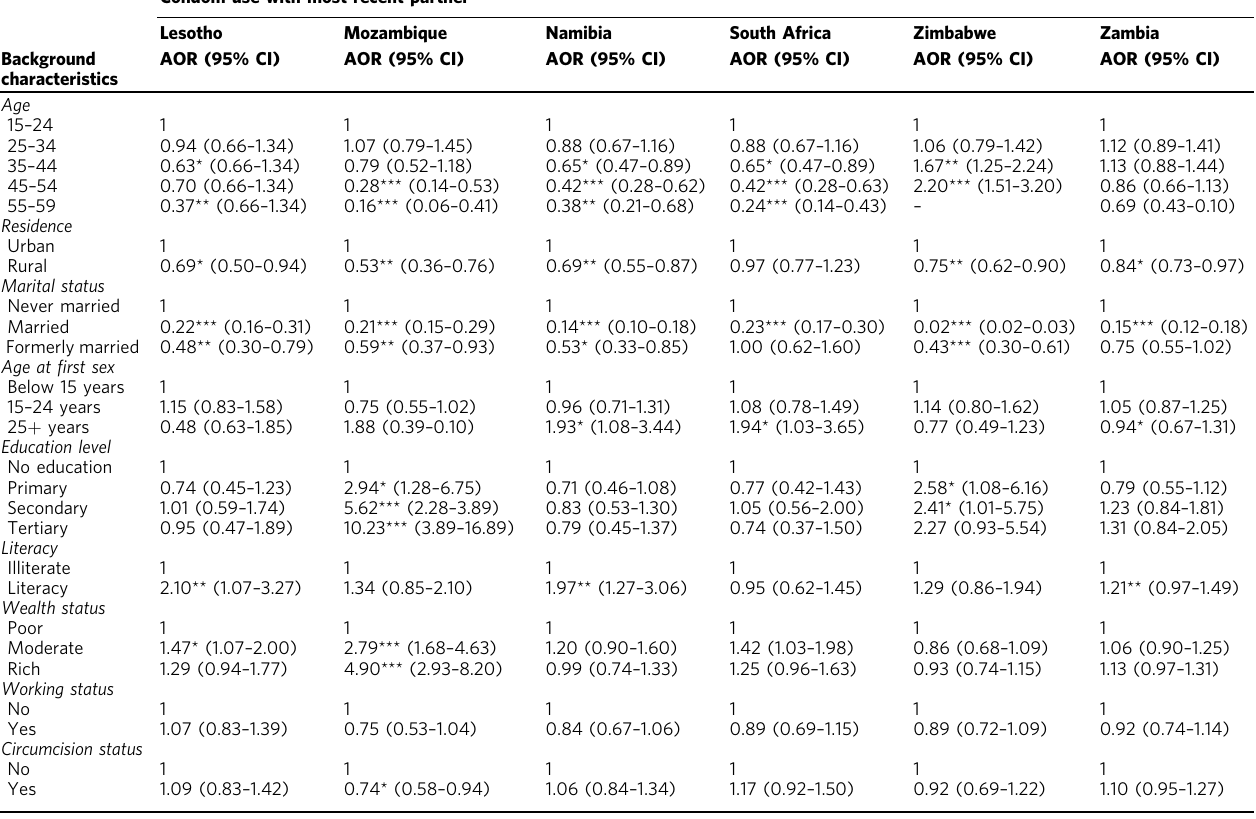
Table 5 Results of multivariate analyses examining the effect of individual-level factors on HIV risk behaviour among men by country in Southern Africa